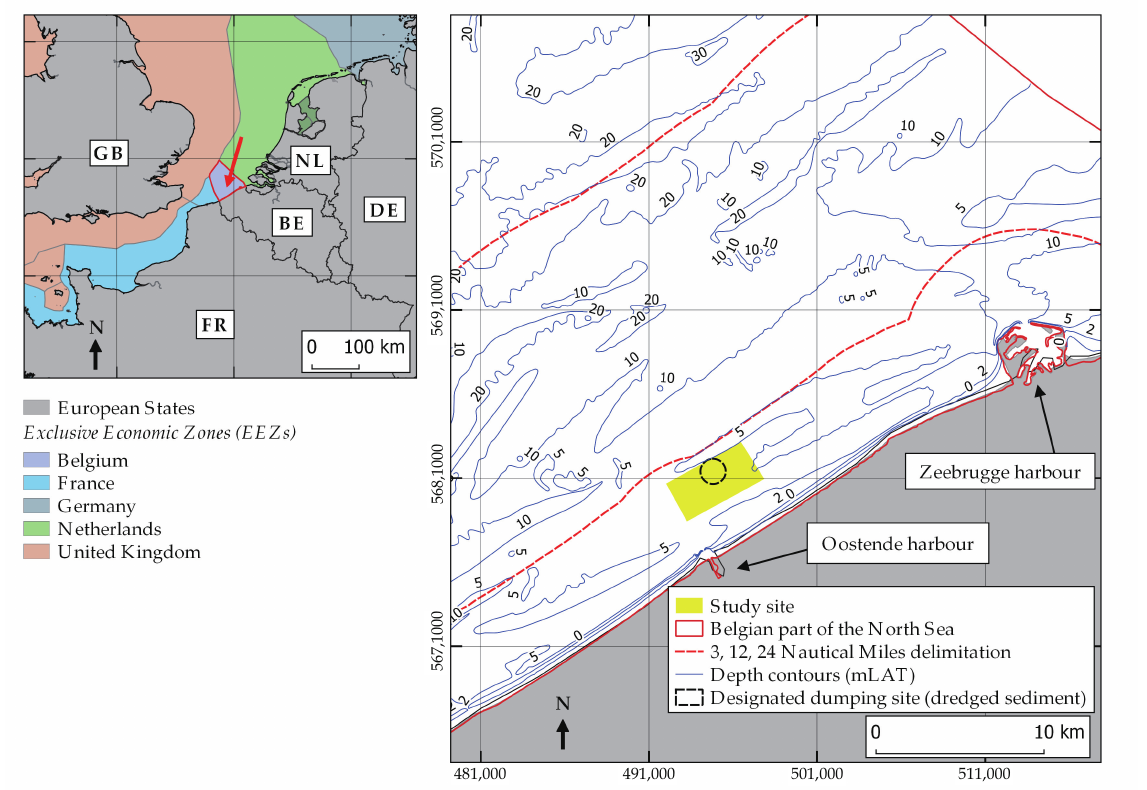
Figure 1. Location of the survey area. All spatial data were projected in Universal Transverse Mercator (UTM) Zone 31 North with Datum World Geodetic System (WGS) 1984. The depth contours were made available from the Agency for Maritime Services and Coast–Coastal Division–Flanders